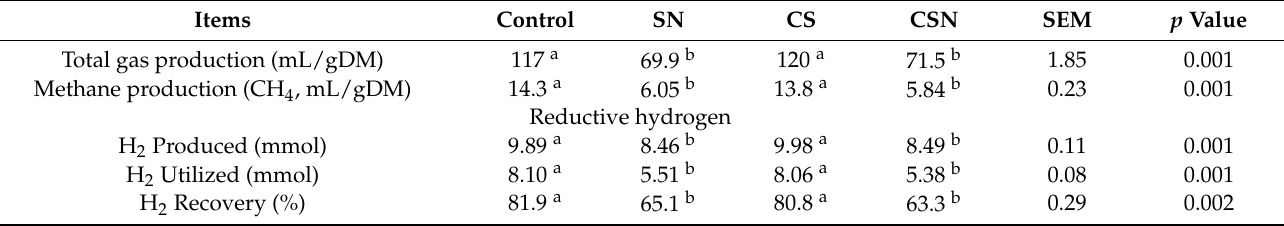
Table 2. Effects of sodium nitrate (SN), cysteamine hydrochloride(CS), and combination of CS and SN (CSN) supplementation on in vitro ruminal batch culture total gas production, methane emission, and reductive hydrogen (0–72